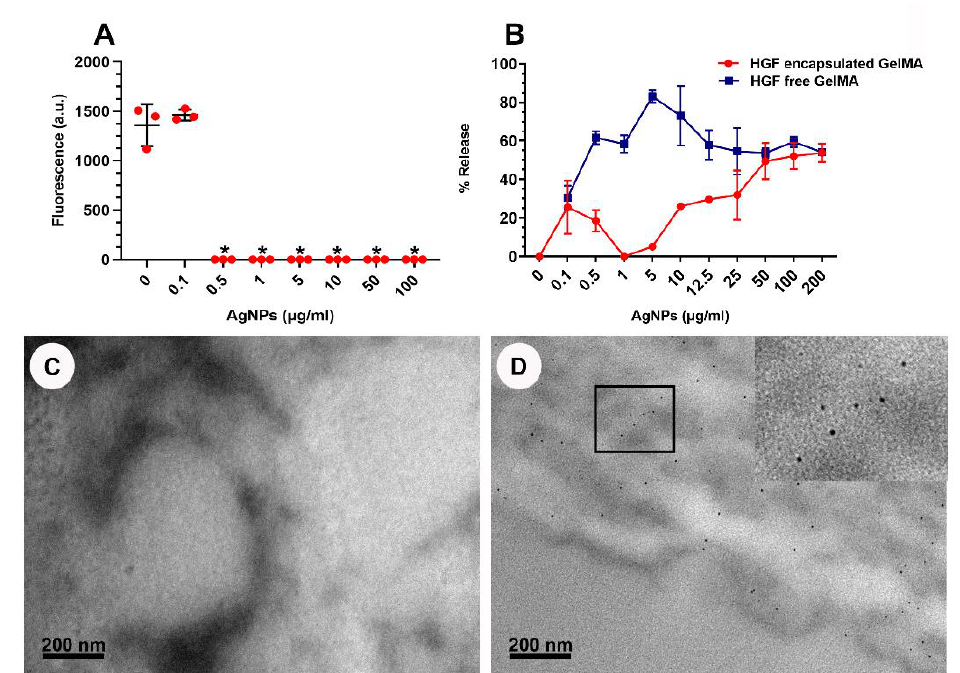
Figure 6. Top: ( A ) Graph showing cytotoxicity of AgNPs on human gingival fibroblasts after 48 h in GelMA. ( B ) Graph showing AgNPs release from GelMA with and without HGFs. (* p < 0.0001). Bottom: TEM images showing GelMA matrix without uranyl acetate and lead citrate staining. ( C ) GelMA matrix without AgNPS. ( D ) GelMA matrix with AgNPs at 200 µg/mL.